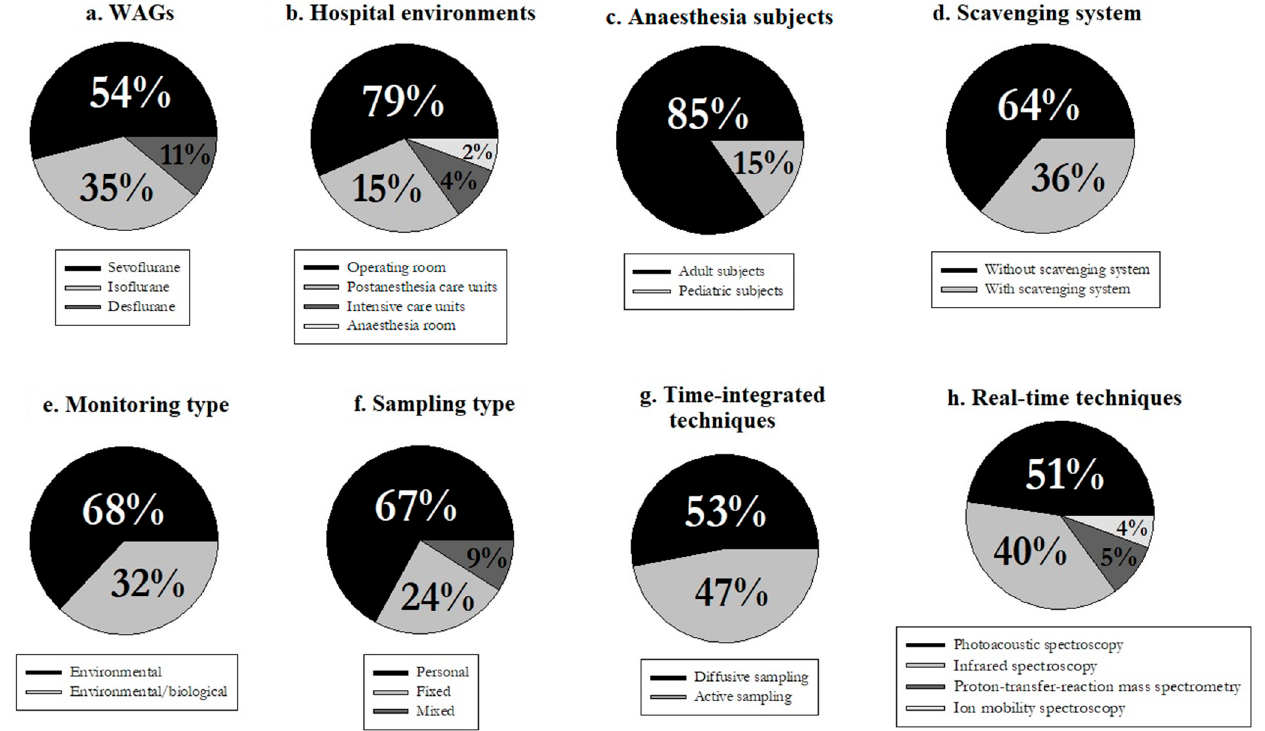
Figure 2. Graphical description (relative frequencies, %) of main characteristics of WAGs exposure monitoring in the investigated literature. ( a ) WAGs; ( b ) hospital environments; ( c ) anaesthesia subjects; ( d ) scavenging system; ( e ) monitoring type; ( f ) sampling type; ( g ) time-integrated techniques; ( h ) real-time